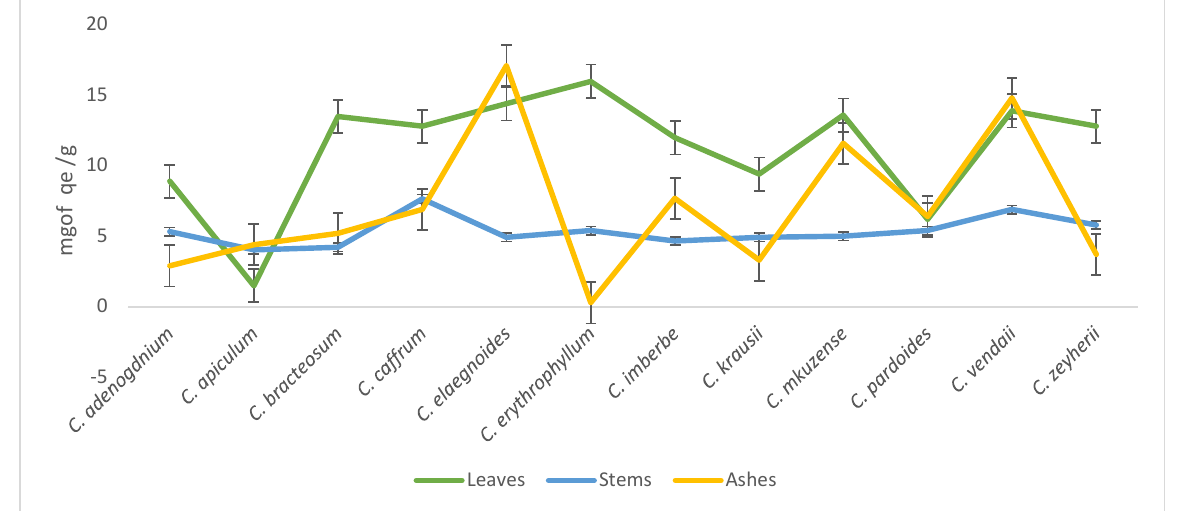
Figure 3. Total flavonoids content concentrations of the 70% aqueous acetone extracts of twelve Combretum species.